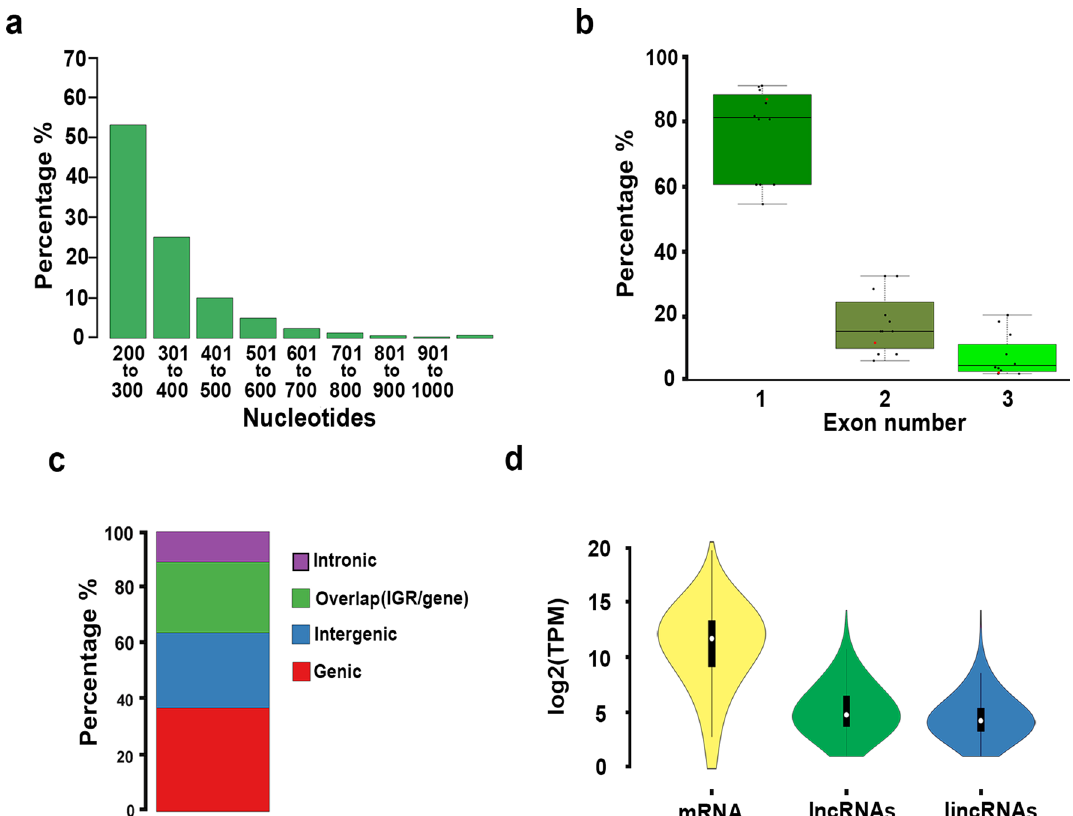
Figure 1. Architecture and annotation of lncRNAs in U. gibba and other plants. ( a ) lncRNAs size distribution in U. gibba is shown in a barplot grouping each 100-nt in size (X axis) and by percentage of the total (Y axis). ( b ) Structure of lncRNAs in selected plants (Additional file 1: Dataset S1). The box plot groups the proportion of exon number (X axis) by percentage (Y axis) among lncRNAs identified from various plant genomes. ( c ) Genomic annotation of U. gibba lncRNAs. The proportion is from 4295 putative lncRNAs loci identified. Red represents the proportion of lncRNAs mapped to body gene regions; blue shows lncRNAs located in intergenic regions; green indicates those that overlap gene body and intergenic regions. ( d ) Coding and noncoding transcripts expression. The violin plot represents the total of mRNAs, lncRNAs and lincRNAs identified in this study with correspondent